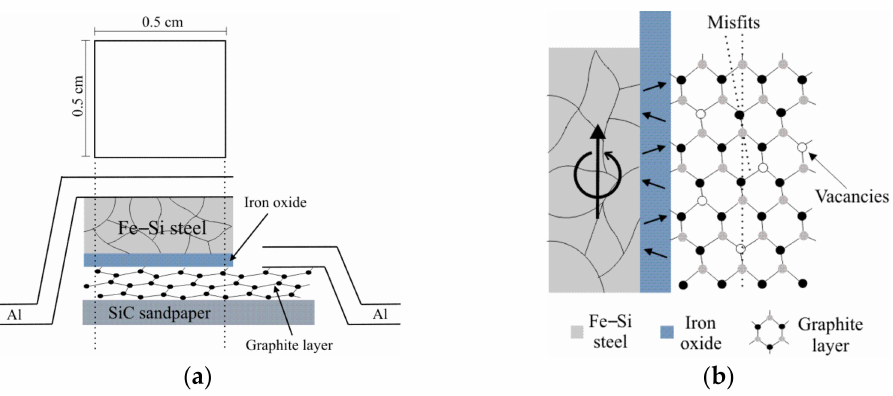
Figure 1. Iron oxide-coupled graphite/Fe–Si steel structure: ( a ) Schematic diagram of the physical array fabricated; ( b ) assembly of the three regions where is shown their magnetic and structural